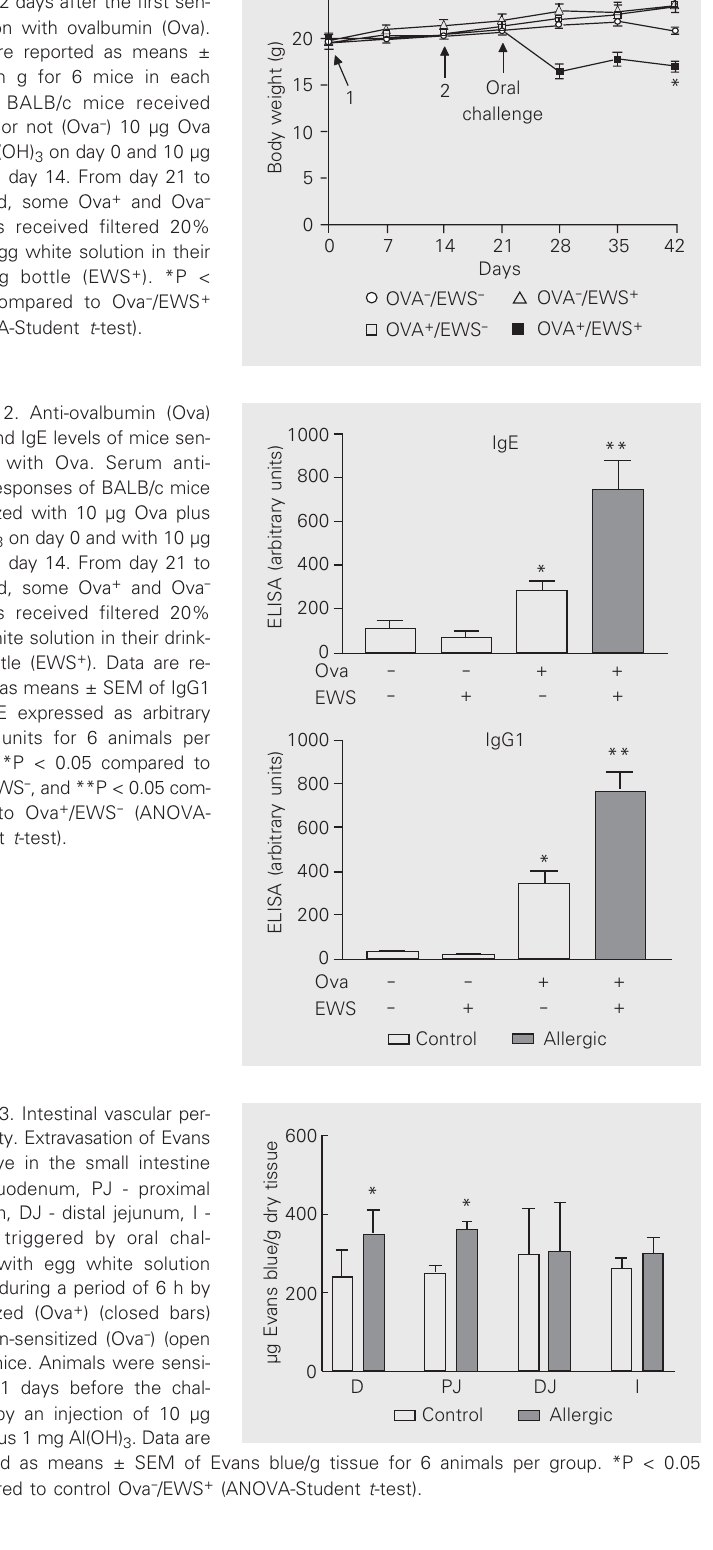
Figure 1. Body weight of mice up to 42 days after the first sen- sitization with ovalbumin (Ova). Data are reported as means ±